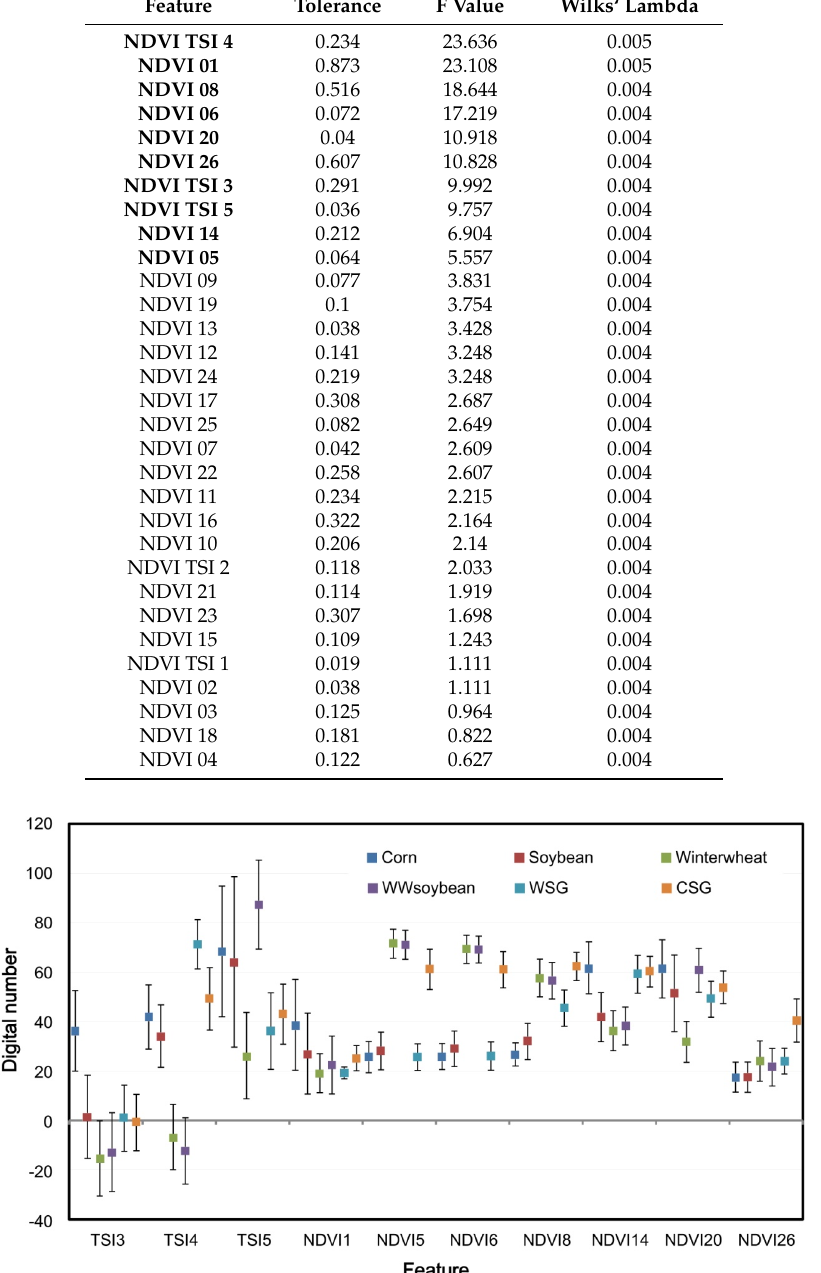
Table 3. F value of 31 features after 10 steps of SDA analysis.